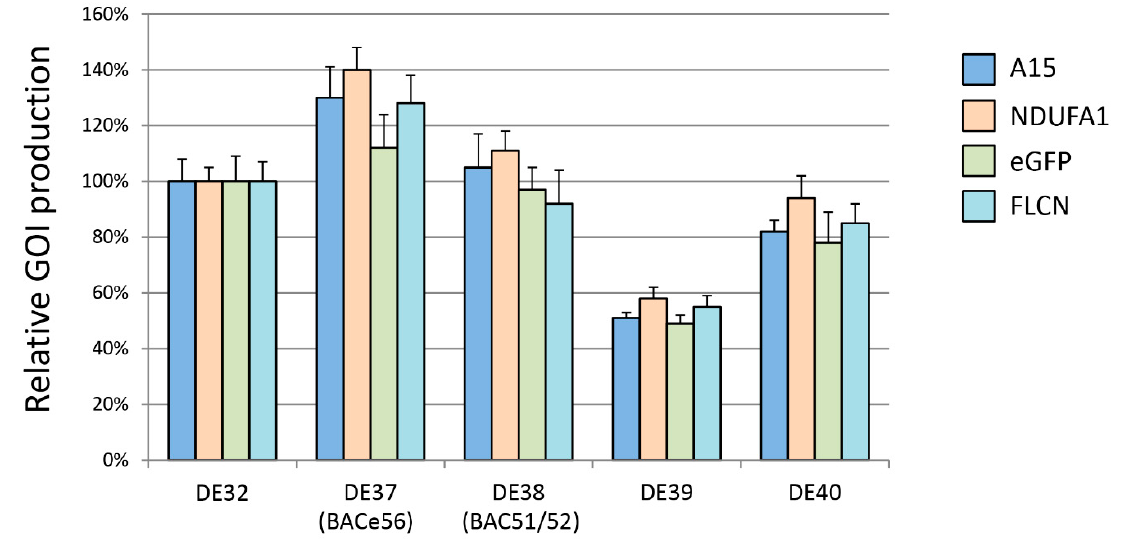
Figure 4. Protein expression in Tni-FNL cells using modified bacmid strains. Protein expression in the modified bacmid strains was measured by green fluorescent protein (GFP) fluorescence (eGFP) or protein quantitation of small-scale IMAC - purified proteins (A15, NDUFA1, FLCN). In all cases, the protein levels were normalized to the level of protein produced in the DE32 control strain. Data represent triplicate measurements and standard deviation is noted with error bars.